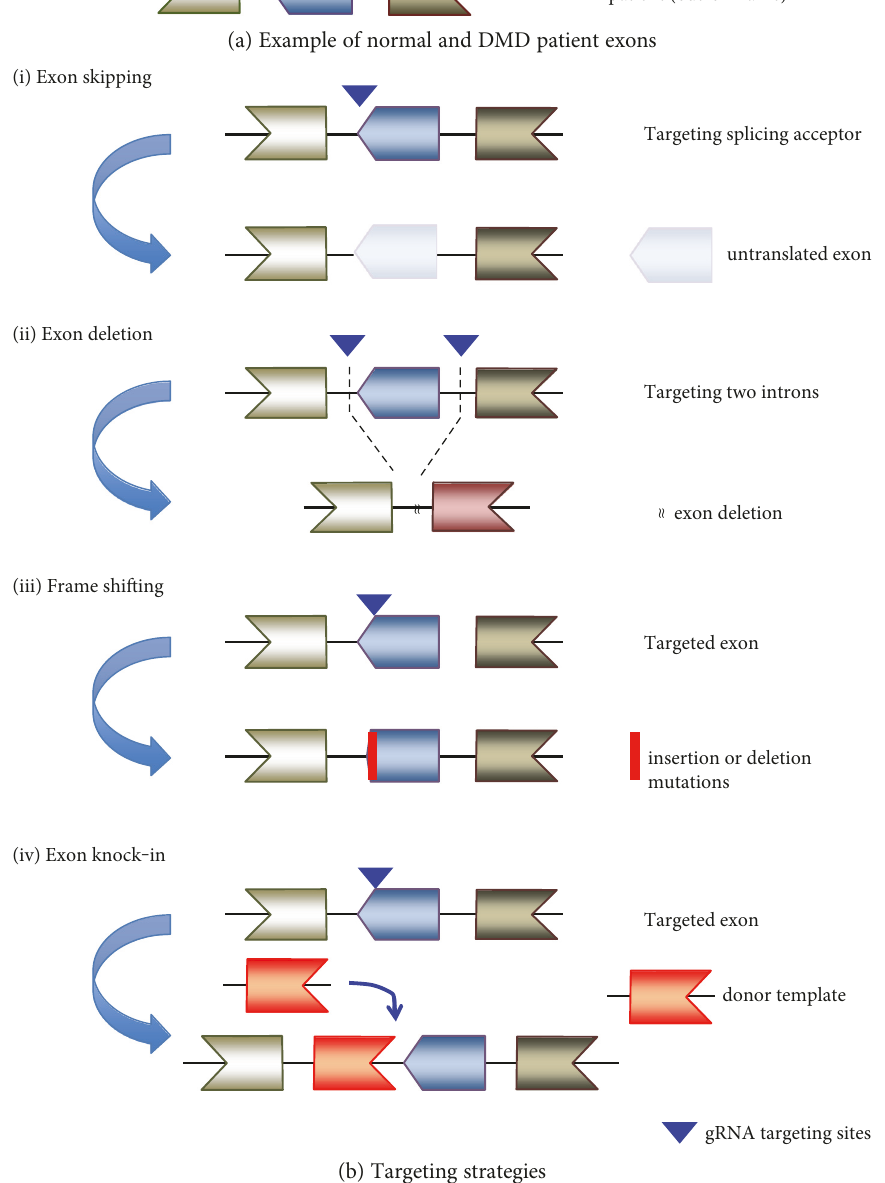
Figure 1: Dystrophin gene targeting strategies by CRISPR Cas9. (a) Examples of normal and patient dystrophin gene exons. Individual exons are represented by beige, dark blue, light blue, and brown. In healthy patient genomes, the exons are in frame and will lead to the expression of a full protein. In DMD patient genomes, the deletion of the dark blue exon leads to a frame shift, disrupting the ORF and causing a premature stop codon. (b) Four main strategies of genome editing to correct the ORF of the dystrophin gene: (i) for exon skipping, sgRNA is designed to target a splicing acceptor. This disruption would mask the exon as an intron, which would not be included in the fi nal mRNA product; (ii) exon deletion involves the complete deletion of a single or multiple exons from the genome. Exon(s) within the range of two targeting sgRNAs would be excised. Mono-exon deletions could be designed for each dystrophin gene mutation type. For a multiexon deletion strategy, exons 45 – 55 (or exons 44 – 54) are deleted and could be applied to up to 60% of DMD patients, although this results in the production of a much smaller dystrophin protein as seen in Becker muscular dystrophy; (iii) another approach to avoid premature stop codons and recover the ORF is by inserting or deleting bases and making frame shifts instead of an exon deletion. NHEJ-mediated insertions or deletions may induce frame shifts and recover the ORF; (iv) dystrophin gene deletion mutations involving one or multiple exons could be rescued by a knock-in strategy of the deleted exon(s) to completely restore full length dystrophin protein expression. In this strategy, a donor template should be delivered in addition to Cas9 and